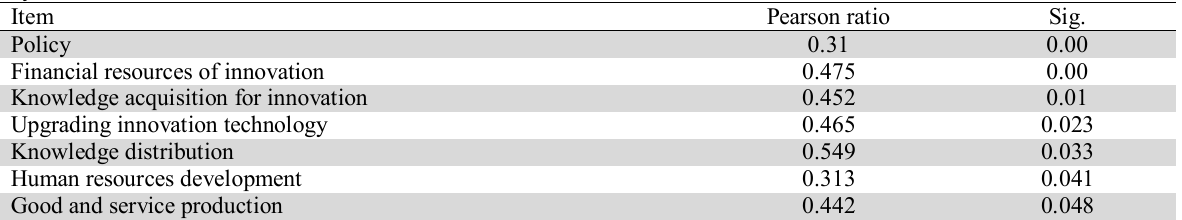
Table 8 indicate that there were positive and meaningful relationships between different components of the survey and development of national innovation system. The highest ratio belongs to knowledge distribution system followed by upgrading innovation technology and Knowledge acquisition for innovation. The summary of Pearson correlation between seven factors with development of national innovation system Item Pearson ratio